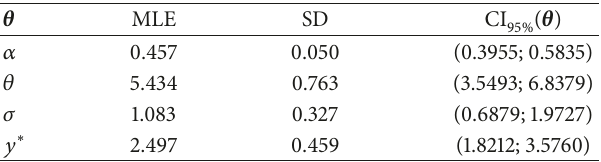
Table 7: MLEs, standard deviations, and 95 % confidence intervals for 𝛼 , 𝜃 , 𝜎 , and 𝑦 ∗ related to the EW distribution.